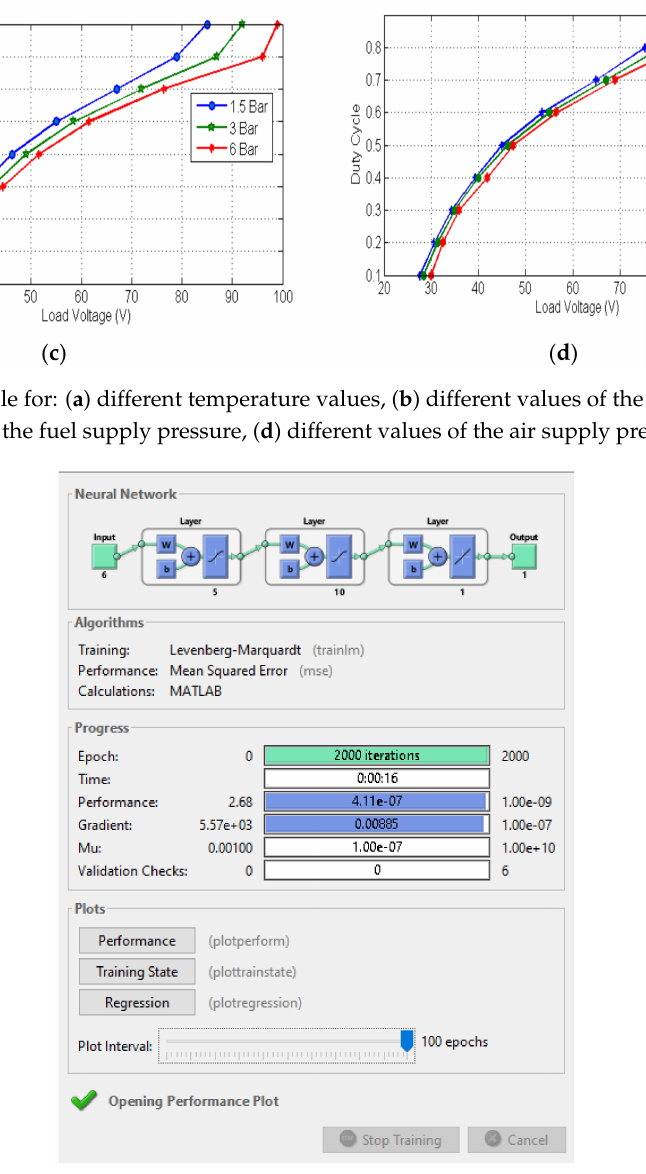
Figure 9. Implementation of the Artificial Neural Network under the